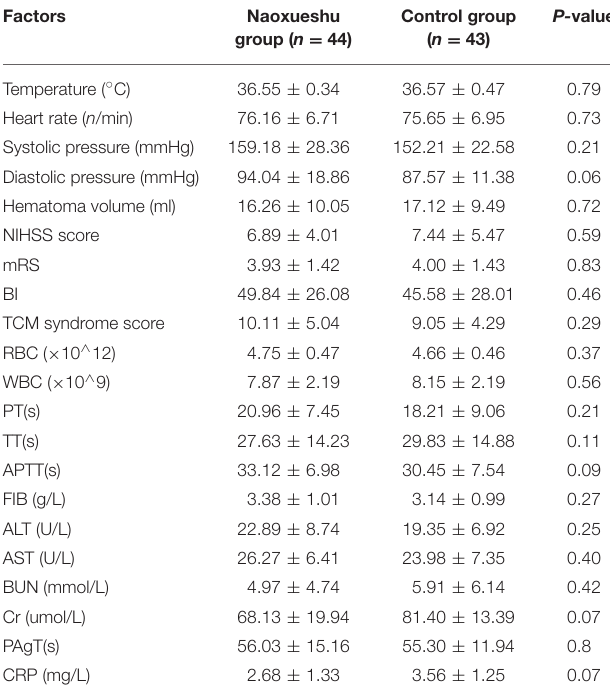
TABLE 2 | Comparison of general clinical information before